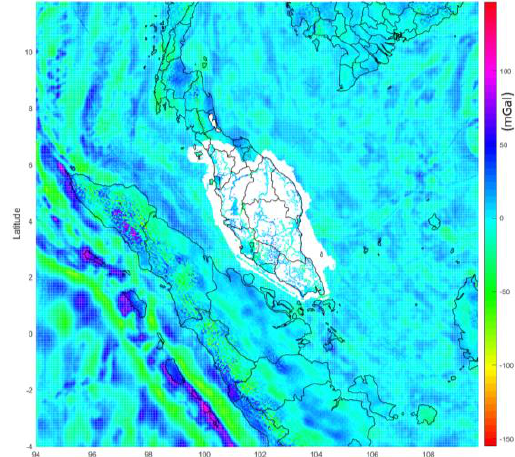
Figure 4 Distribution of land gravity anomalies and DTU17 over Peninsular